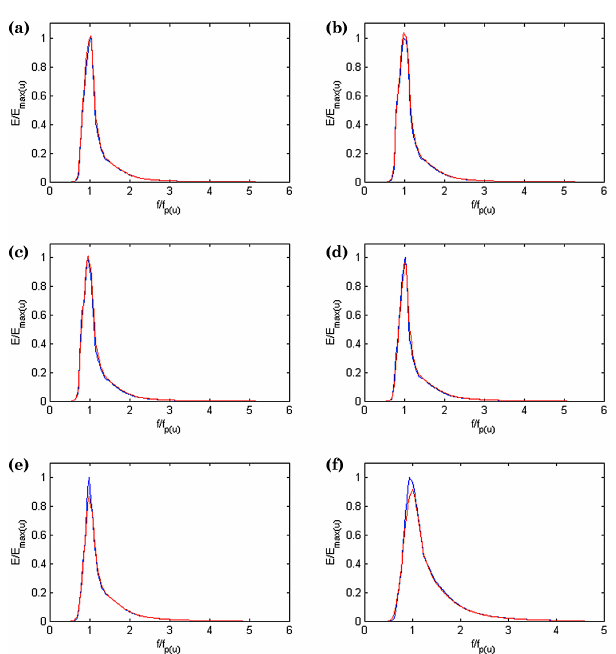
Figure 20. Modelled 1-D spectrum in the Firth of Forth wave gauge, the red line is the coupled model (with WCIs incorporated), while the blue line is the uncoupled model: (a) 31 March 2010 at 00:30, (b) 31 March 2010 at 01:15, (c) 31 March 2010 at 02:00, (d) 31 March 2010 at 04:15, (e) 31 March 2010 at 06:00, and (f) 31 March 2010 at